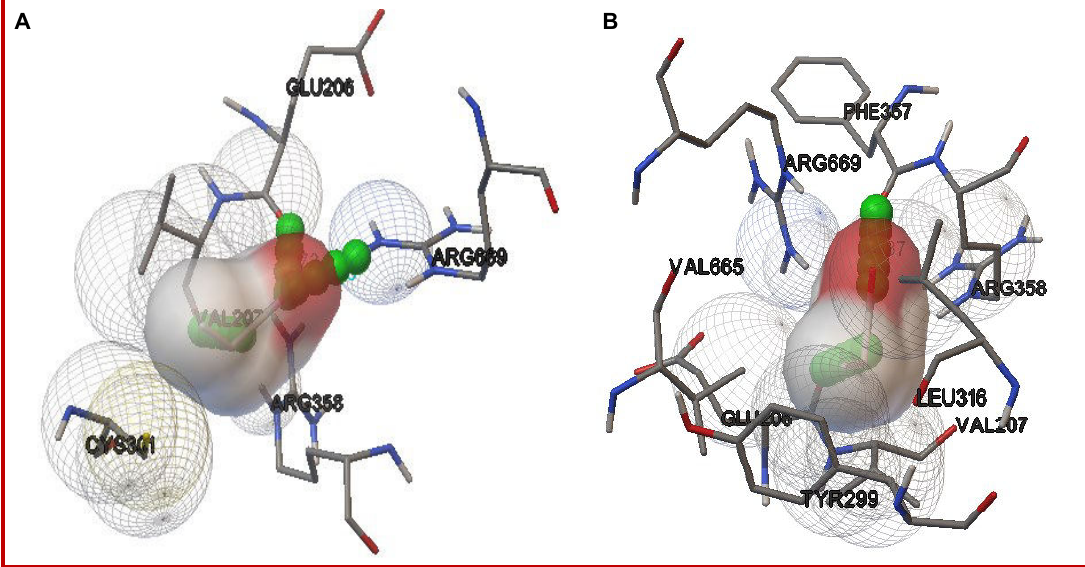
Figure 6: Inhibitory action of acrylamide with DPP-IV using AutoDock hydrogen bond interaction A) A chain B) B chain